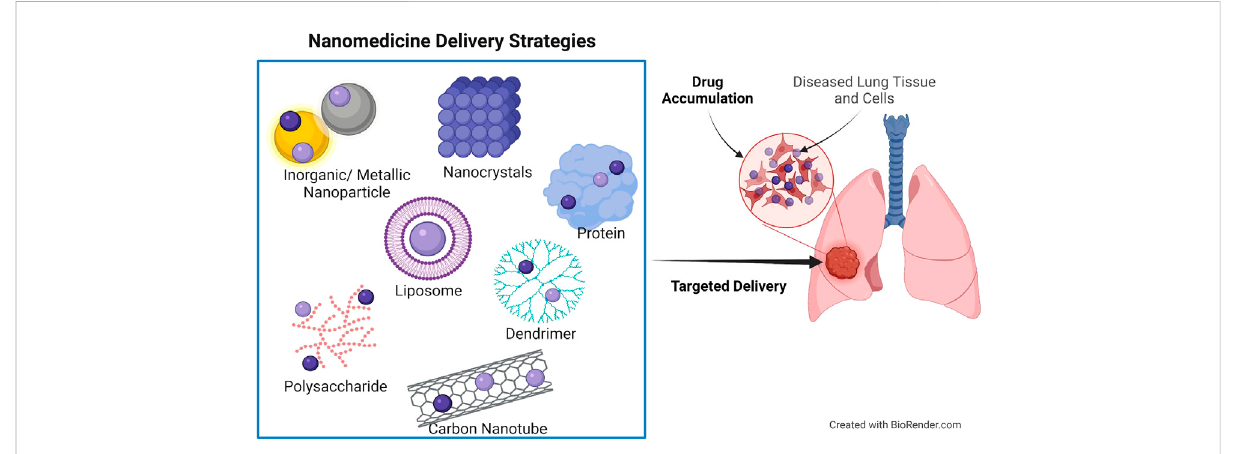
FIGURE 3 Nanodrug delivery systems used for site-targeted distribution and improved bioavailability. Protein and polysaccharide nanoparticles, liposomes, dendrimers, inorganic/metallic nanoparticles, nanocrystals, and carbon nanotubes are all examples of nanoparticles used in